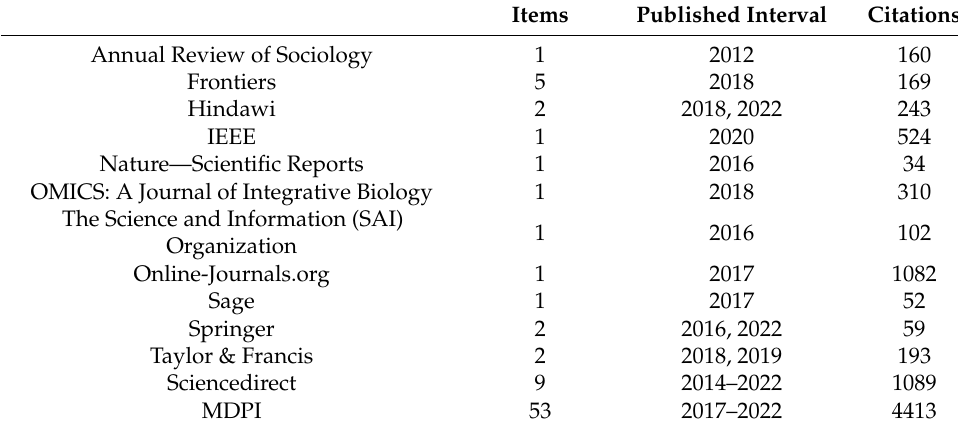
Table 2. Articles from indexed journals (per publisher).